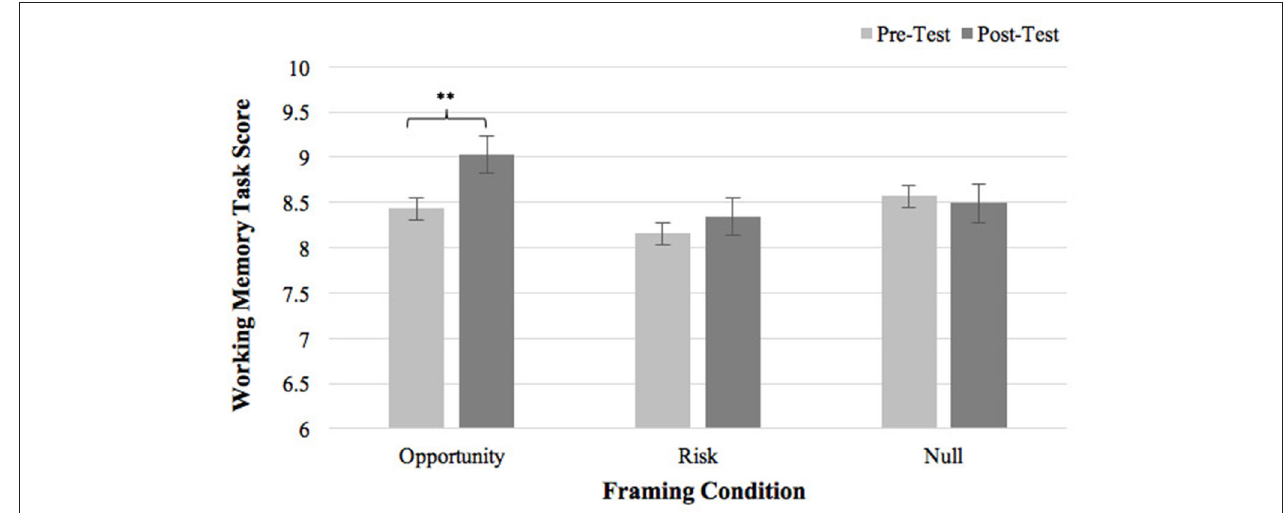
FIGURE 2 | Pre- and post-framing WM scores in three framing conditions. Error bars represent standard errors. ** p < 0.01.